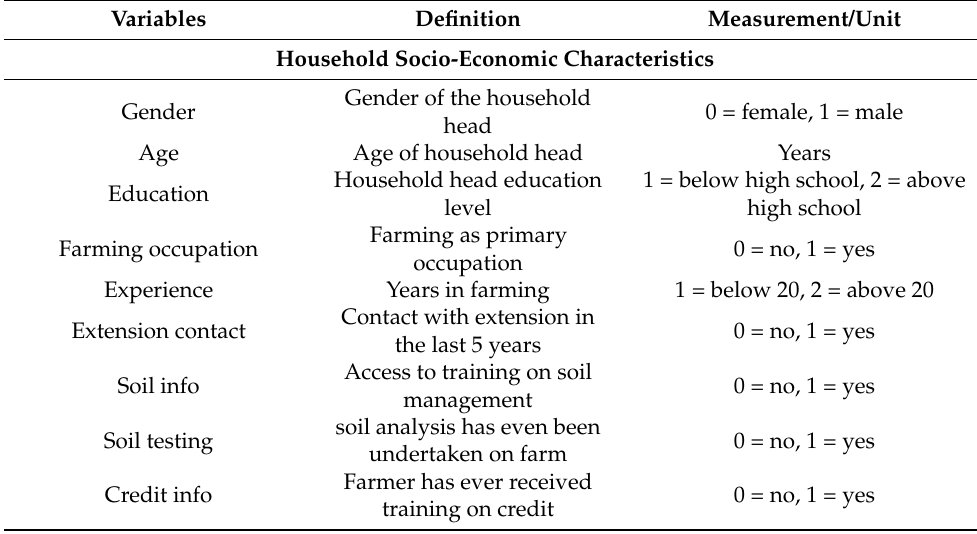
Table 2. The selected socio-economic characteristics and soil fertility management practices used for farm